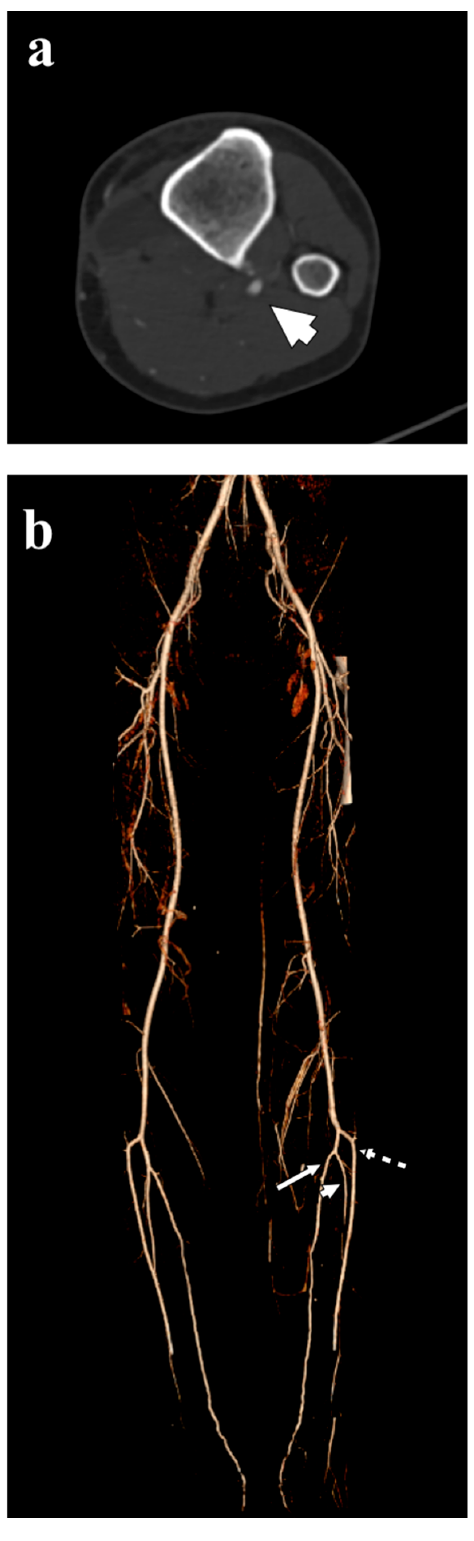
Figure 3. Postoperative examination. ( a ) Axial CT scan with contrast show the complete removal of the tumor and the vascular bundle (arrowhead). ( b ) Three-dimensional volume rendered CT angiography image shows complete revascularization of the anterior tibial artery (dashed arrow), peroneal artery (arrowhead) and posterior tibial artery (flat arrow).